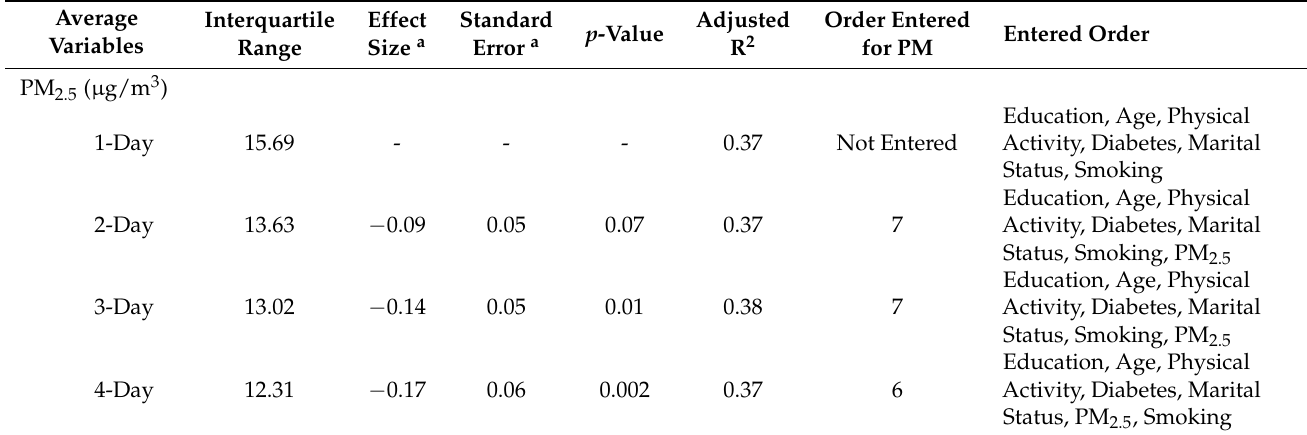
Table 5. Relationship between exposure to PM 2.5 and PM 10 and cognitive score as determined by a forward selection model (n =